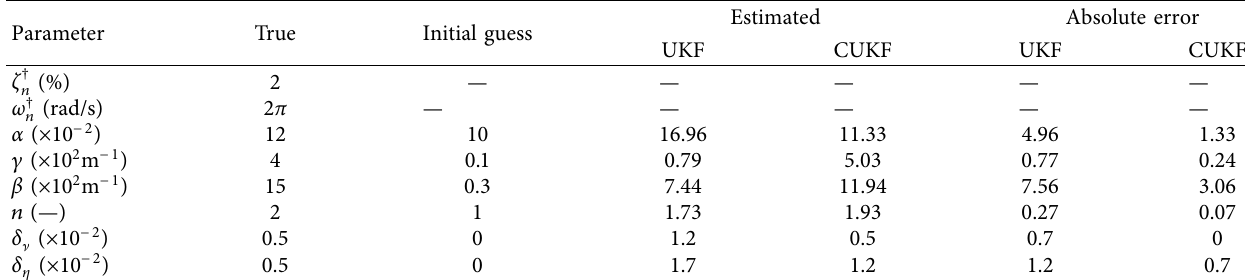
Figure 7: Results of parameter identification for Example 3. Table 3: Model parameters used in Example